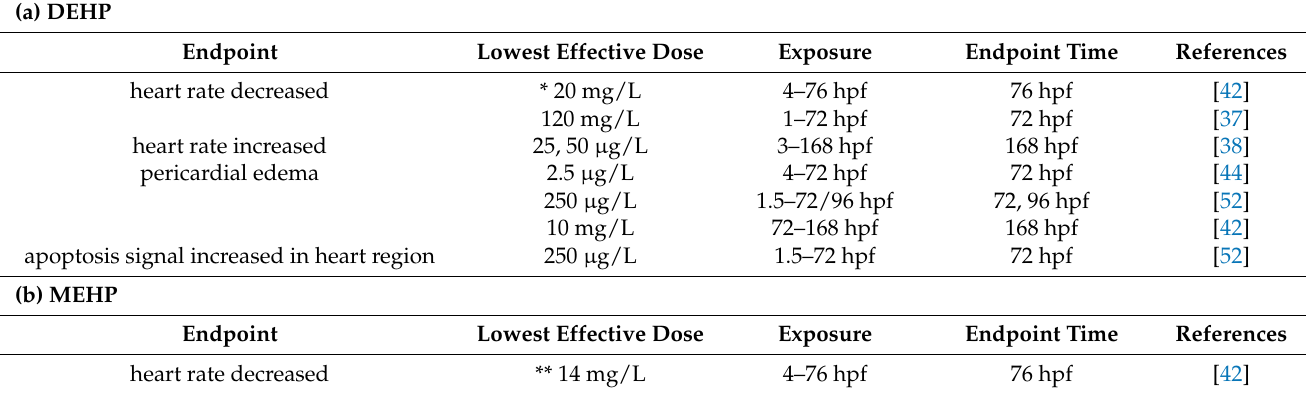
Table 3. Cardiovascular toxicity from acute exposures to (a) DEHP and (b) MEHP on zebrafish. * The concentration was converted from nM or µ M using the molar mass of DEHP 390.57 g/mol. ** The concentration was converted from nM or µ M using the molar mass of MEHP 278.34